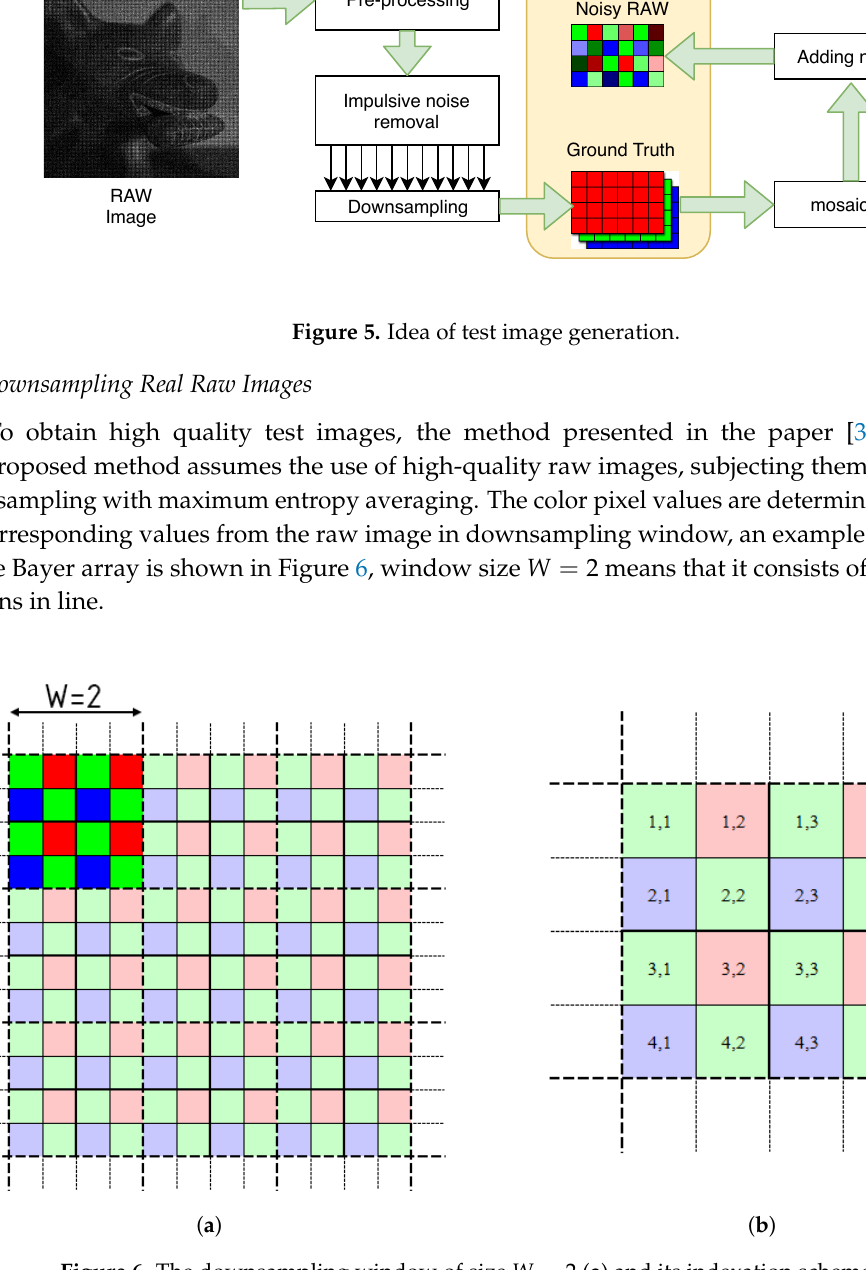
Figure 6. The downsampling window of size W = 2 ( a ) and its indexation scheme ( b